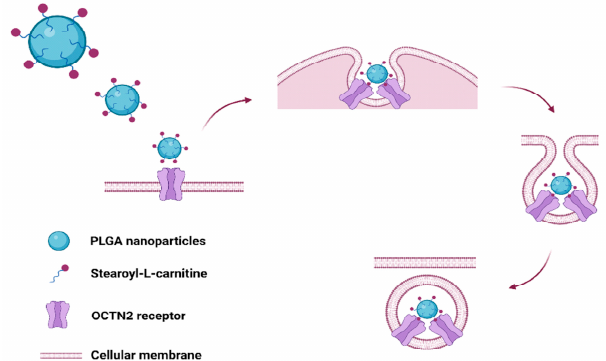
Figure 1. Cellular uptake of SC-PLGA nanoparticles: functionalized nanoparticles bind to OCTN2 receptor on the cell membrane, forming a complex that is then internalized into the cell (created with BioRender.com).